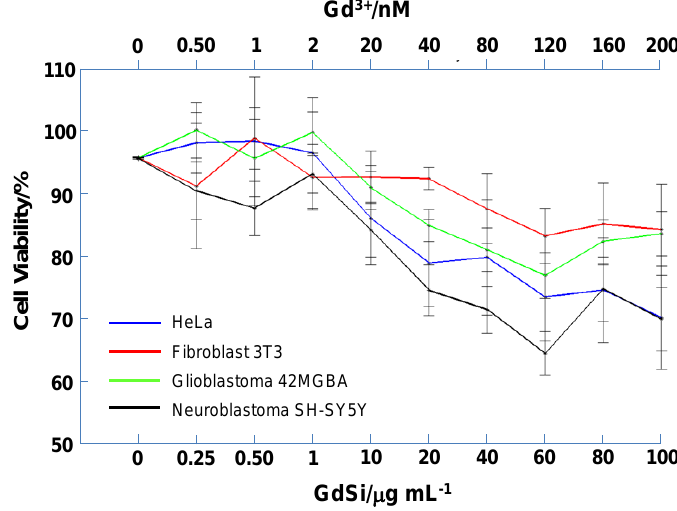
Figure 7. In vitro 3-(4,5-dimethylthiazol-2-yl)-2,5-diphenyltetrazolium bromide (MTT) cell viability assays in different cell lines incubated with variable concentrations of GdSi magnetic nanorods (mean ± SEM, n = 4). Top X -axis indicates the concentration of equivalent Gd 3+ .